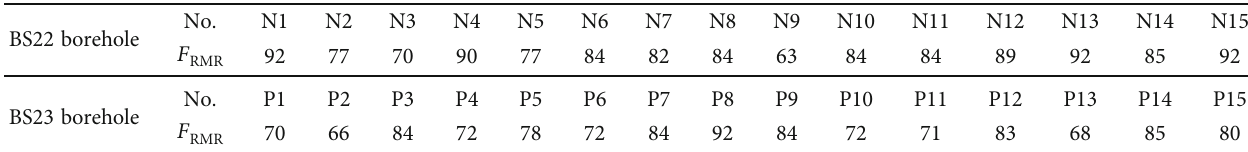
Table 8: F RMR values of the outcrops around BS22 and BS23 boreholes.